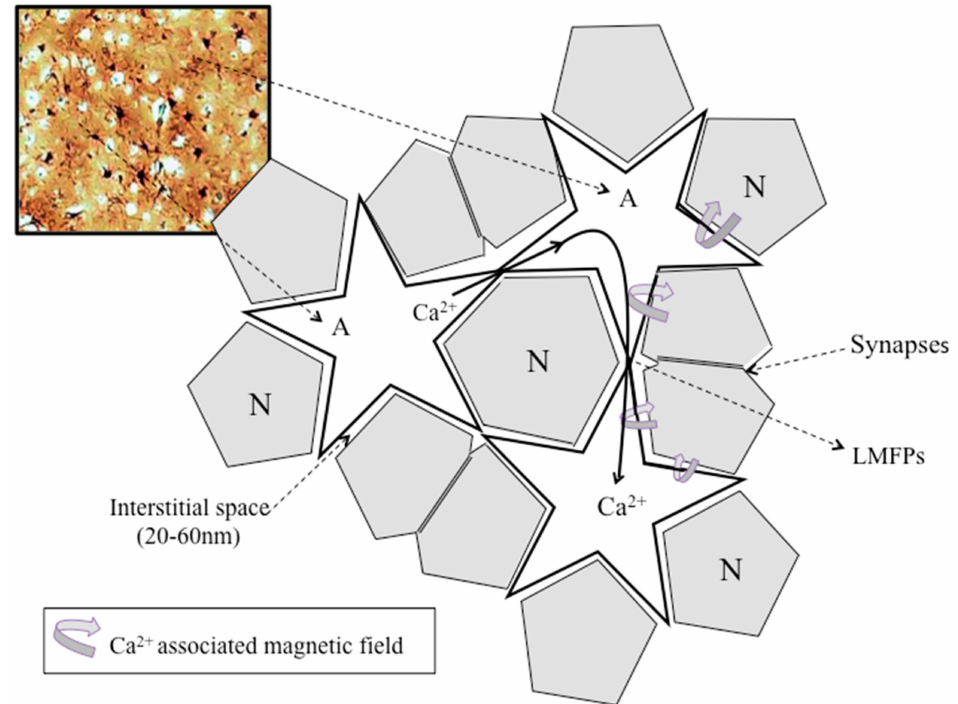
Figure 4. Schematic representation of neurons (N) and astrocytes (A) in layer 2–3 of the human neocortex. Astrocytes are stellated white cells connected by gap junctions. The astroglial matrix surrounds neuronal axons and dendrites. The interstitial space is near virtual (20 to 62 nm width) in physiological conditions. The addition of synaptic currents, action potential currents, and astroglial ionic currents generate local field potential (LFP) in the intercellular space with their corresponding local magnetic field potential (LMFP). Ca 2 + waves generate current gradients into the astroglial network with their inherent bioelectric and biomagnetic fields that modulate adjacent neuronal behavior by influencing the LFPs and